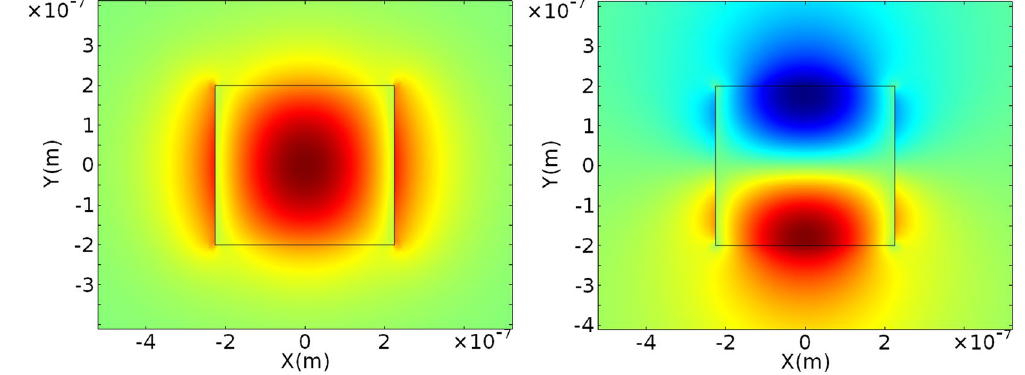
Figure 2. Calculated quasi – TE fundamental mode for the 400 × 450 nm waveguide at 1550 nm, and the first order quasi-TE mode for the waveguide at 1310 nm.